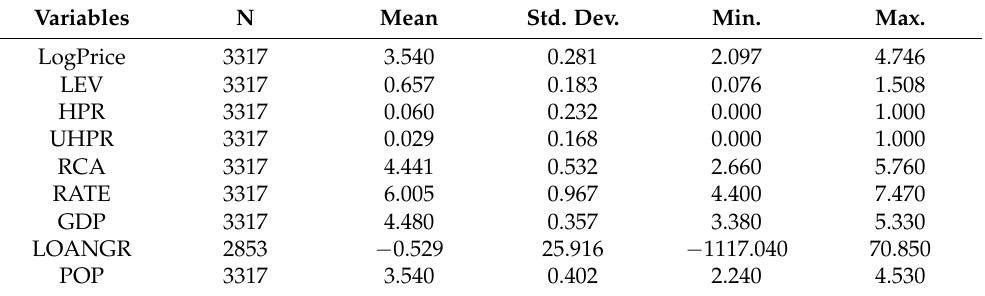
Table 2. Summary statistics of the